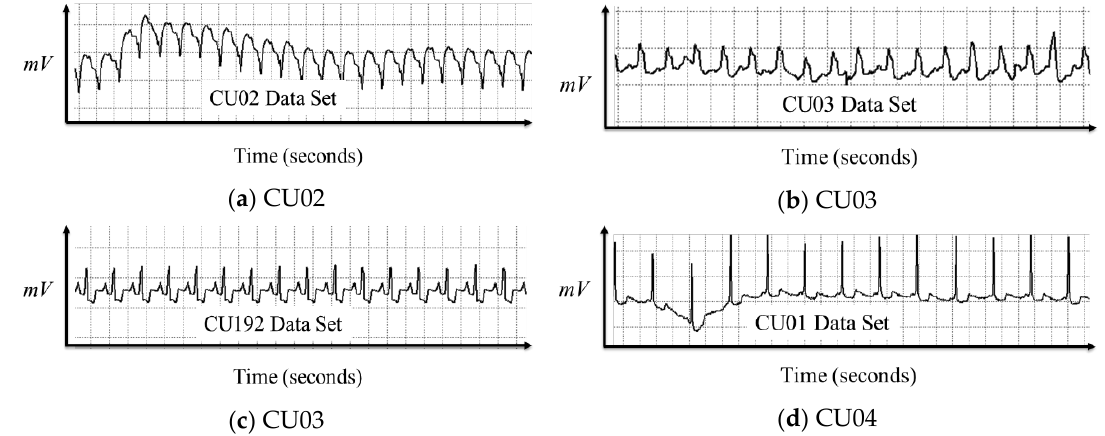
Figure 5. The turning point between a sinus rhythm and the VF event.